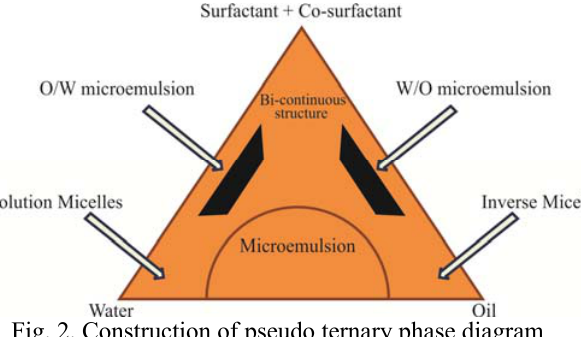
Fig. 2. Construction of pseudo ternary phase diagram